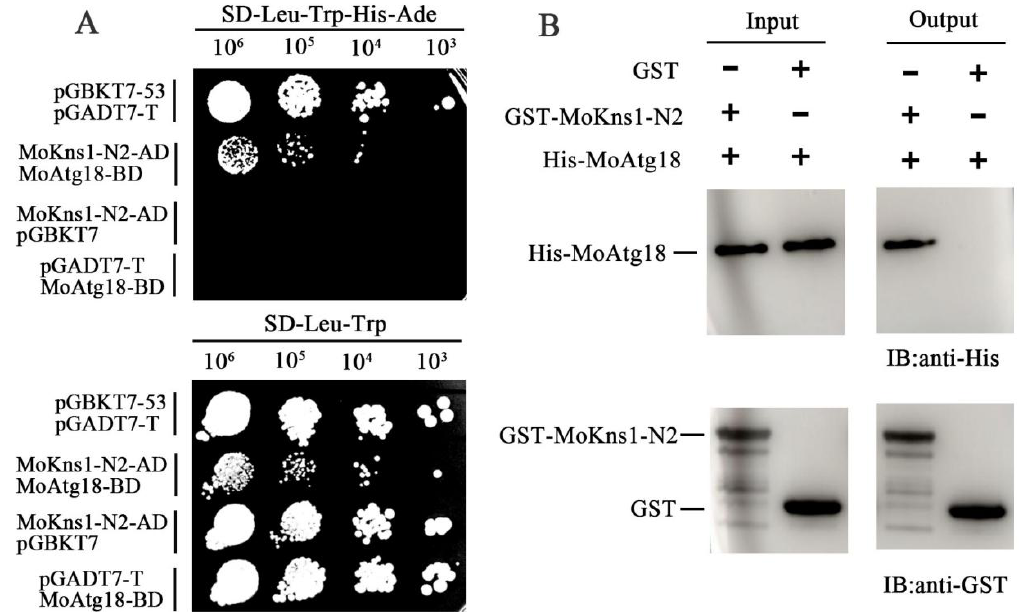
Figure 5. MoKns1–N2 interacts with MoAtg18. ( A ). Yeast two-hybrid analysis. The pair of plasmids pGBKT7 − 53 and pGADT7 − T was used as the positive control. The plates were incubated at 30 °C for 3 days before being photographed. ( B ). Pull-down assays. Recombinant GST–MoKns1–N2 or GST bound to glutathione Sepharose beads was incubated with an E. coli cell lysate containing His − MoAtg18. The eluted proteins were analyzed by immunoblotting (IB) with the monoclonal anti − His and anti − GST antibodies.